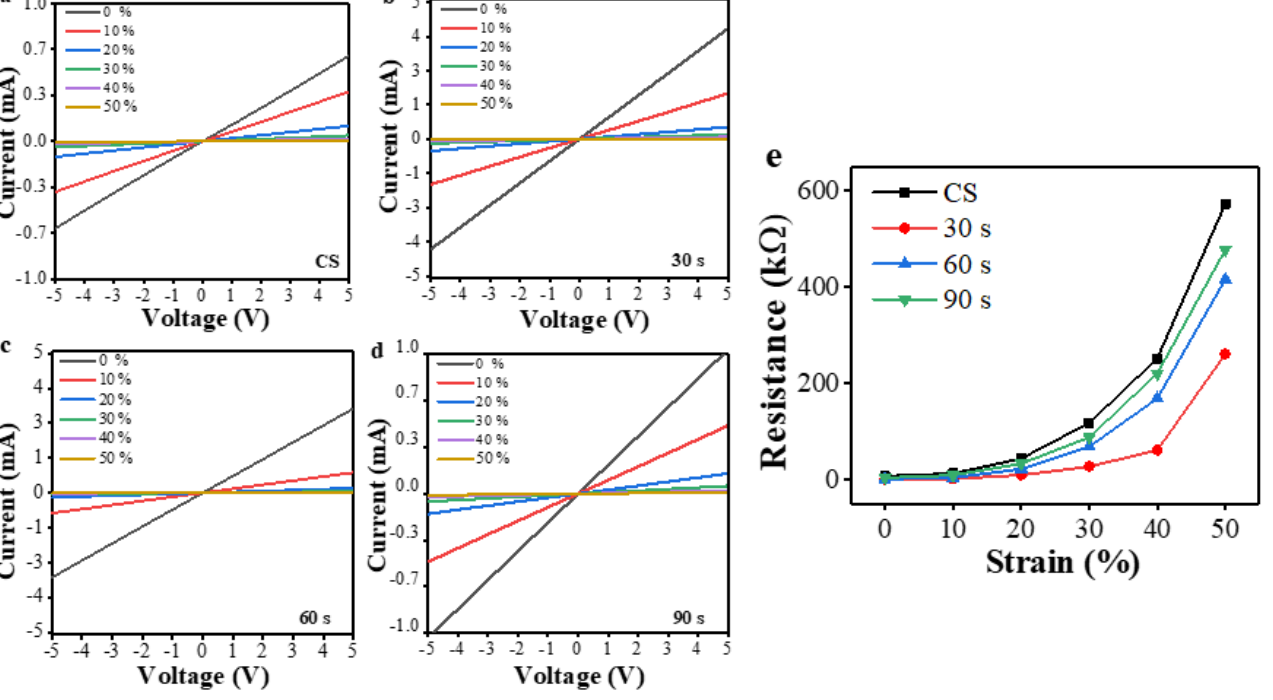
Figure 4. I–V characteristics measured under the axial strain ranging from 0 to 50% from the multi- layer PPy/PDMS strain sensors fabricated with various O 2 PT time intervals of ( a ) 0 (CS), ( b ) 30, ( c ) 60, and ( d ) 90 s. ( e ) Electrical resistances measured from the plasma-treated sensors for various time intervals are shown upon the change of film strain from 0 to 50%.